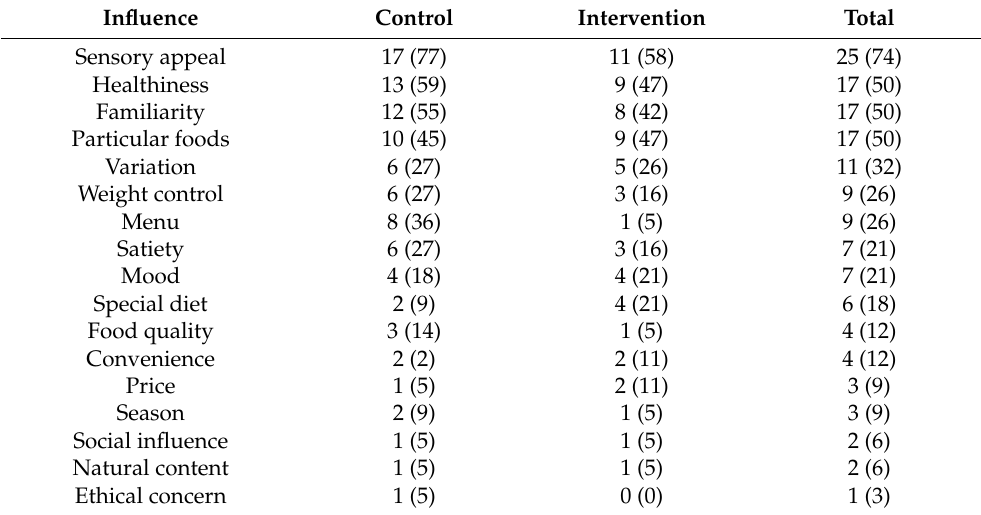
Table 5. The number (%) of individuals that mentioned each perceived influence on food choices. Control n = 22, intervention n = 19, total n = 34 1